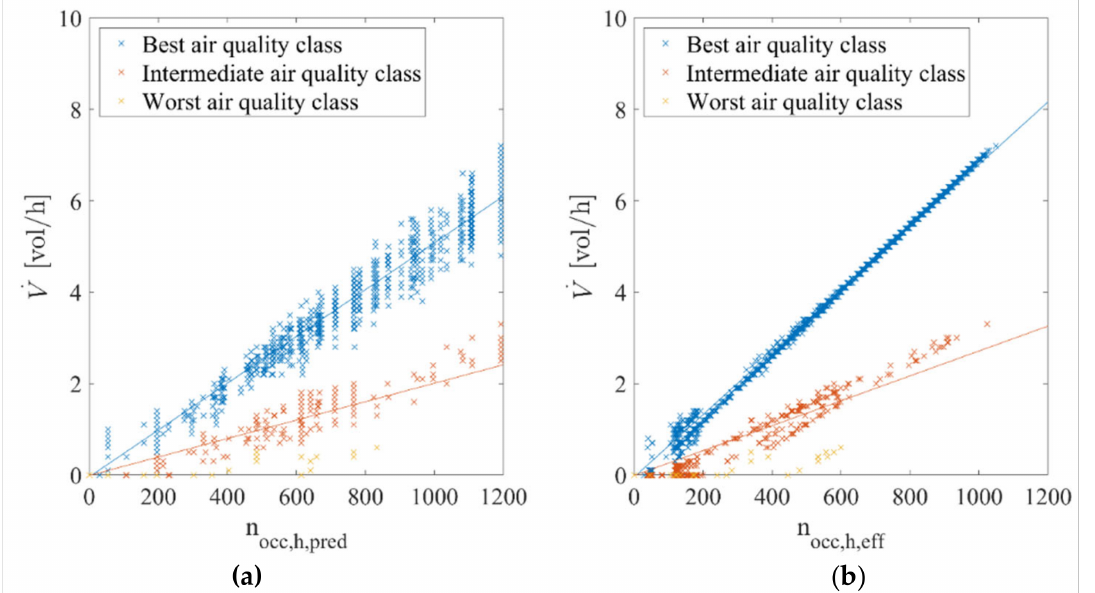
Figure 8. Ventilation rate as a function of predicted hourly occupancy ( a ); ventilation rate as a function of “effective” hourly occupancy ( b